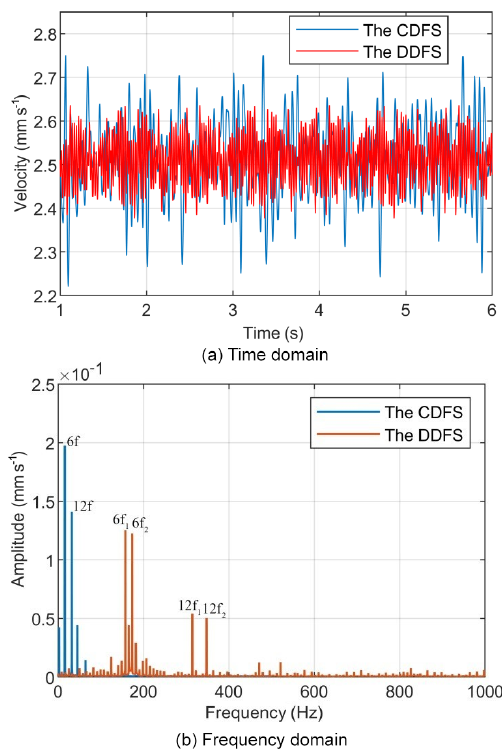
Figure 6. Comparison of the table velocity fluctuations of CDFS and DDFS when the nut servo motor speed is 300rpm in the